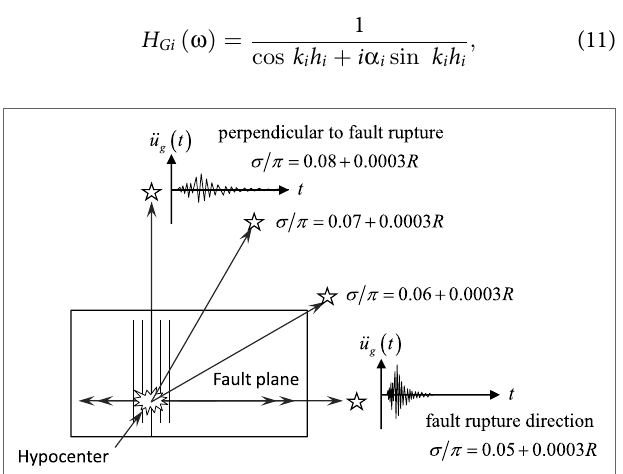
FIGURE 2 | SD of phase difference at observation site for plate boundary earthquake [replotted based on Yamane and Nagahashi (2008)].